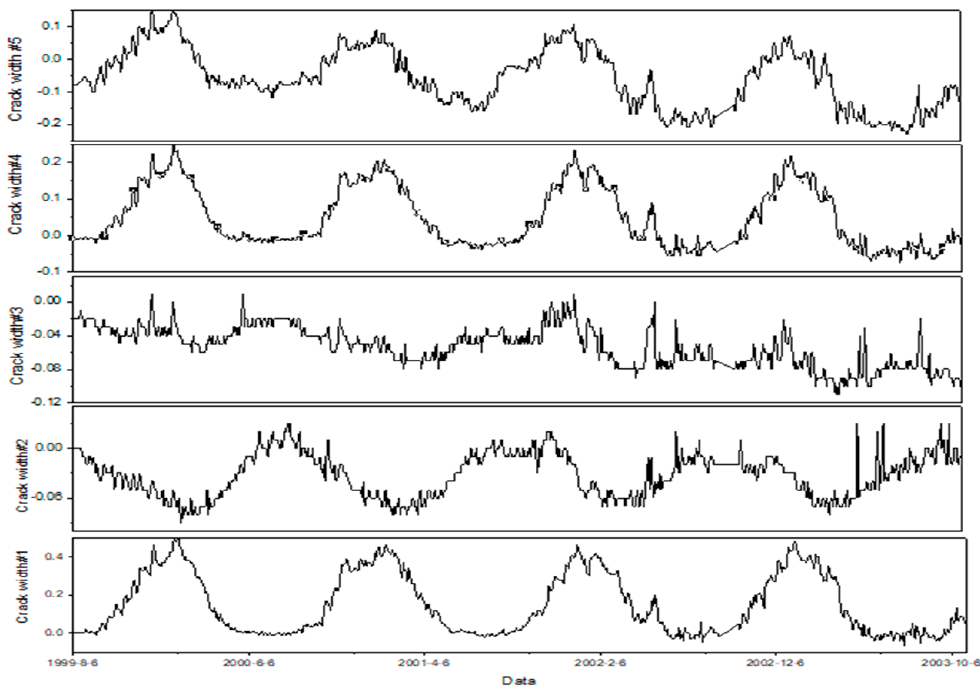
Figure 10. The variation of crack width for five monitoring points at dam section #12. Table 8. The weight variation of three dam section at five time periods.